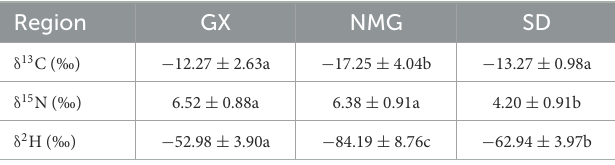
δ 2 H from bone to gelatin samples during processing to evaluate the effectiveness of these factors as geographical origin indicators ( p < 0.01) (20, 29). The linear discriminant analysis (LDA) was used to